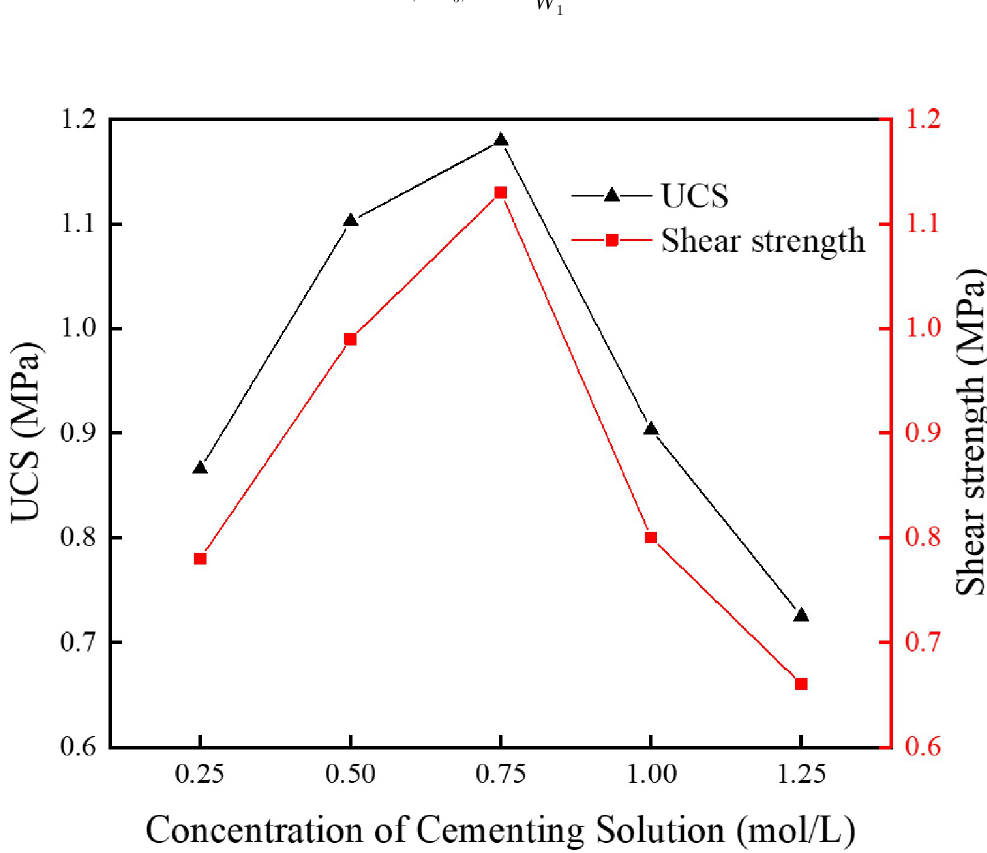
Fig 10. Relationship between cementing solution concentration and mechanical